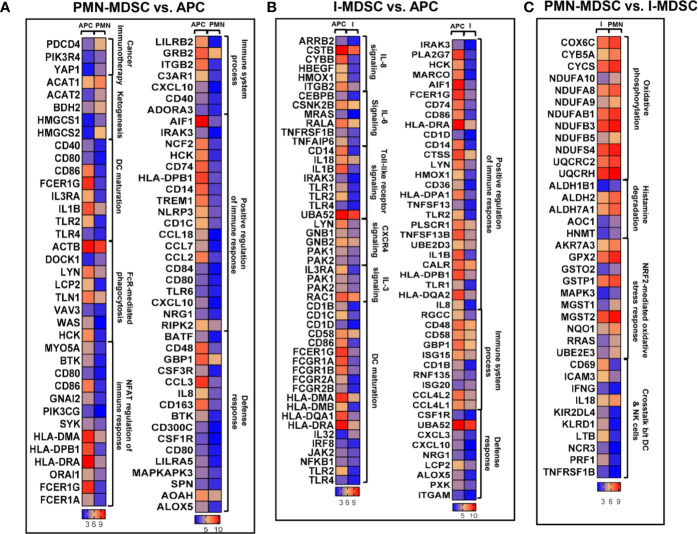
Differential gene expression of PMN-MDSCs, I-MDSCs and APCs in CRC tumor microenvironment. Functional categorization of top significantly upregulated and downregulated transcripts (with a fold change > 2, P value cutoff < 0.05) from CLC analysis were analyzed through IPA. Heat maps show the TPM representing fold change relative to the mean expression in PMN-MDSC (denoted as PMN) vs. APC (A), I-MDSC (denoted as I) vs. APC (B) and PMN-MDSC vs. I-MDSC (C).